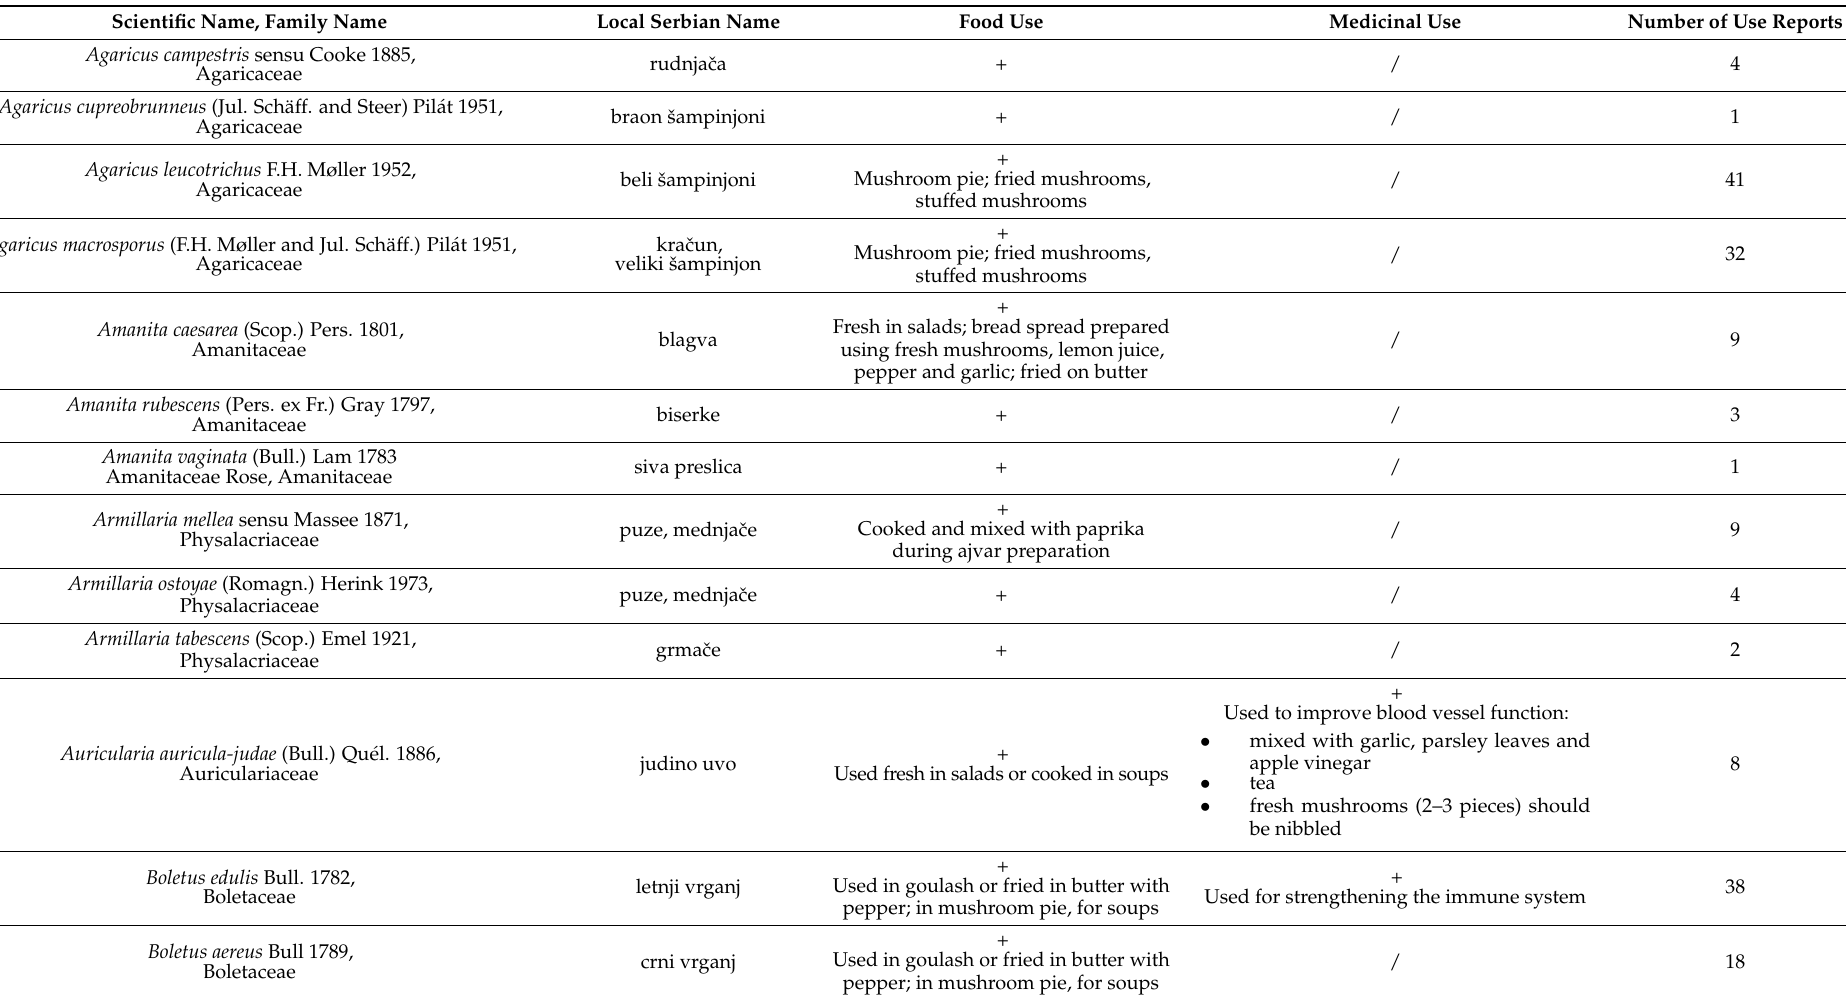
Table 2. Ethomycological data collected on the use of fungi as food and medicines (+ stands for recorded use; / stands for not recorded